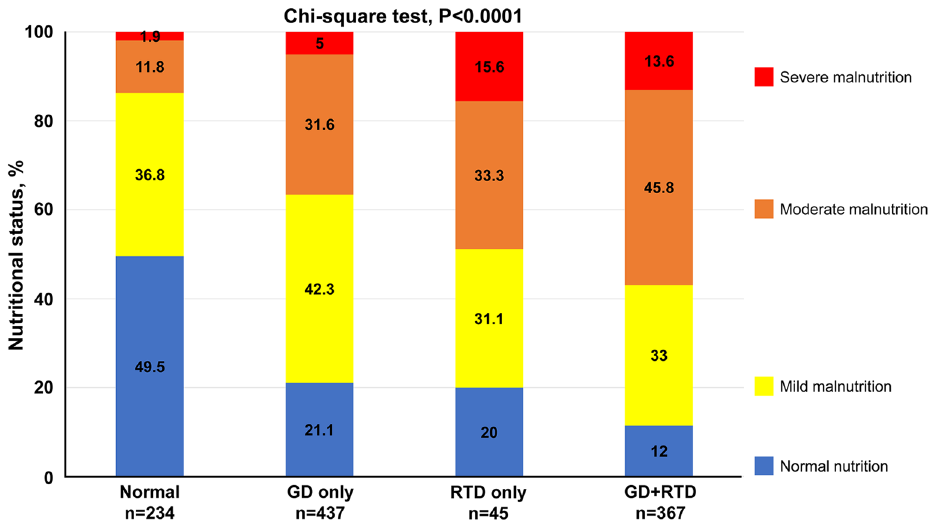
Figure 5. Association between malnutrition severity and type of renal dysfunction. GD glomerular damage, RTD renal tubular